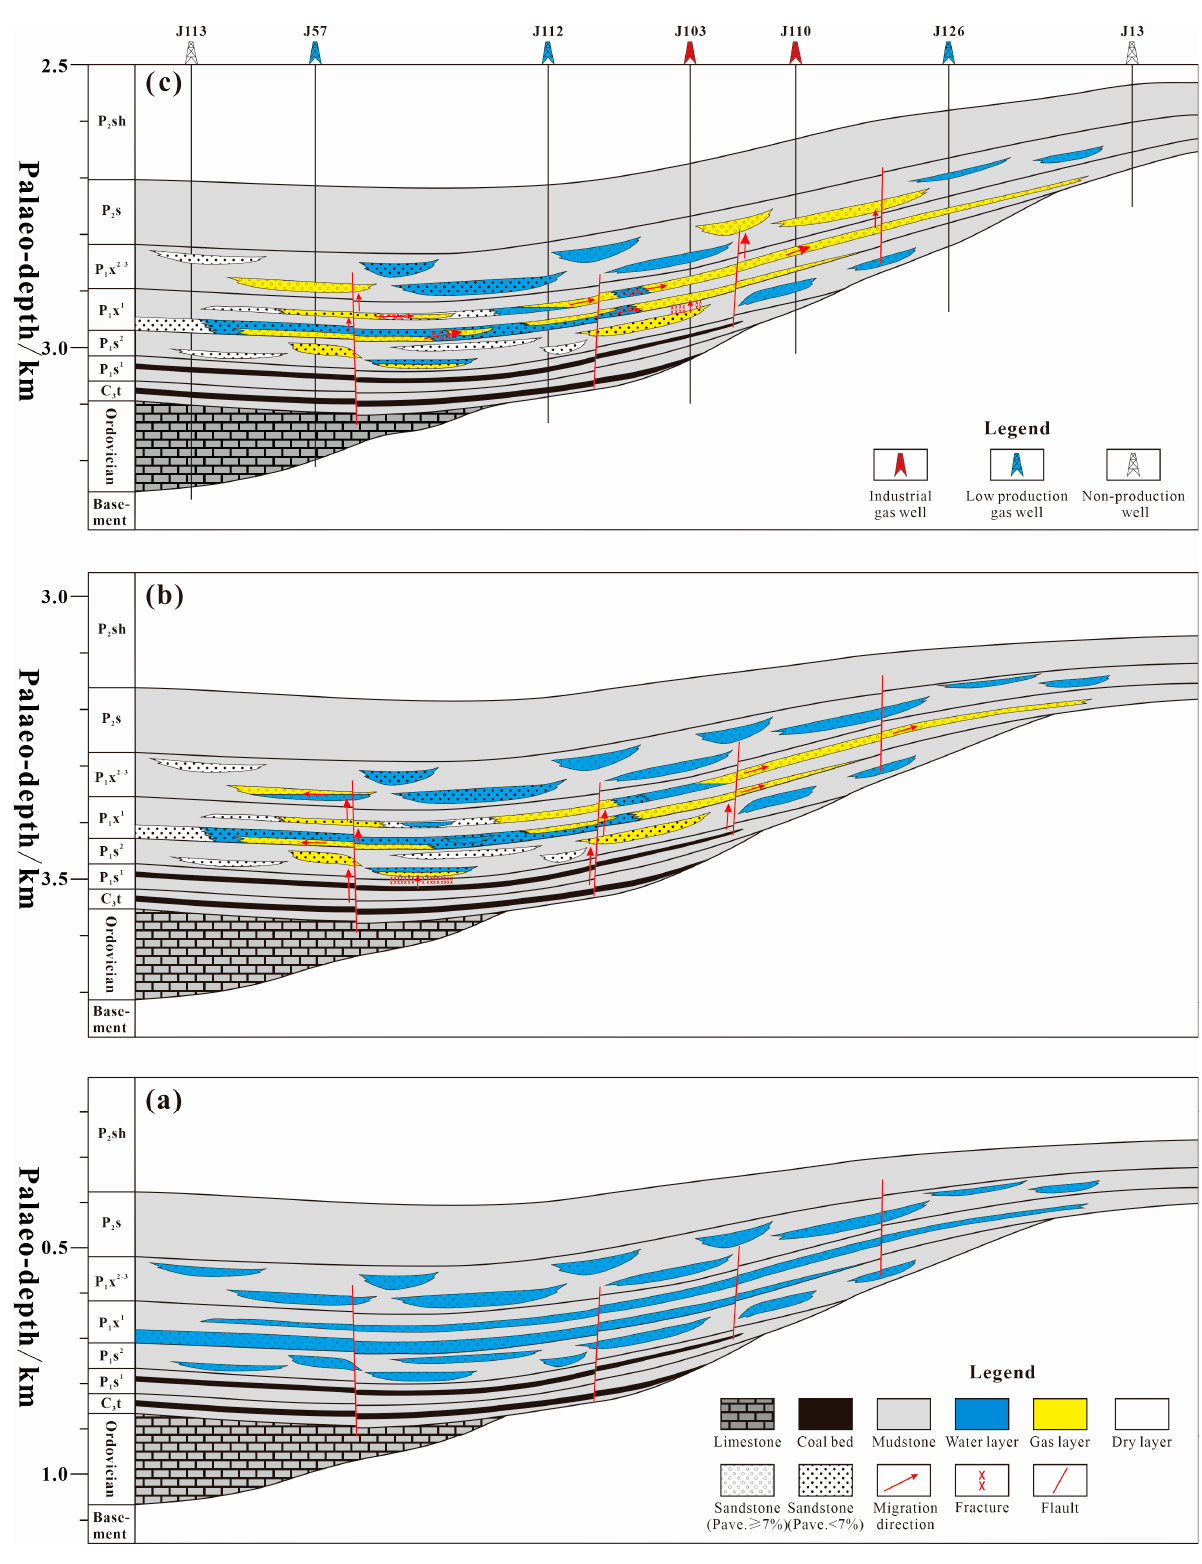
Figure 14. Gas accumulation process of the Lower Shihezi Formation tight sandstone gas reservoir in the Duguijiahan block, northern Ordos Basin, China: ( a ) depositional stage (C–P), ( b ) natural gas accumulation stage (T–K1), and ( c ) gas reservoir adjustment stage (K2–Nowadays). Abbreviations: Pave.: average porosity.